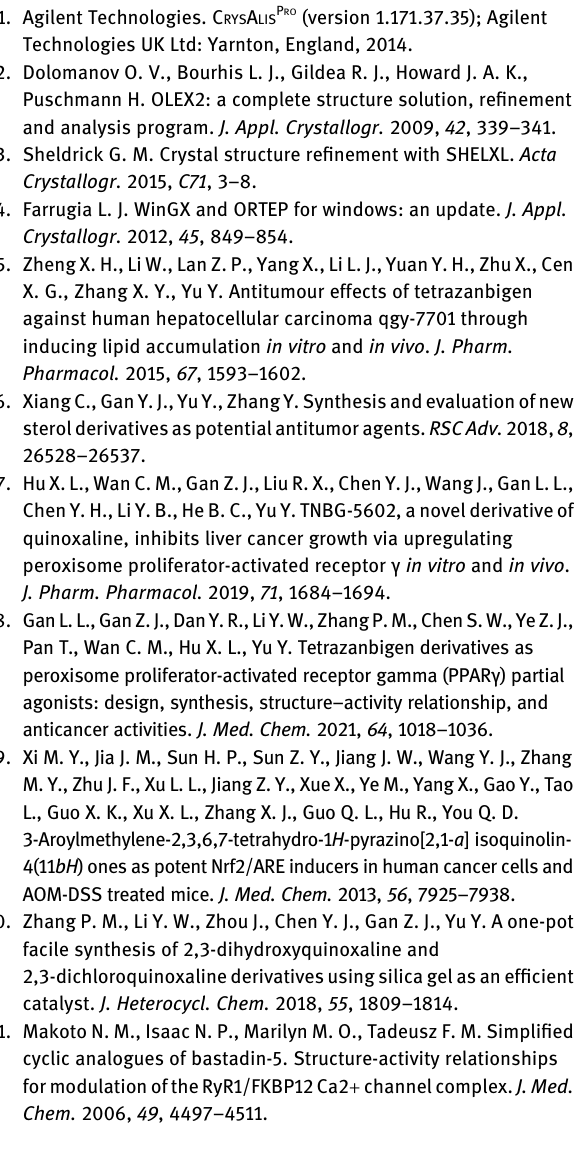
Table  : Fractional atomic coordinates and isotropic or equivalent isotropic displacement parameters (Å 